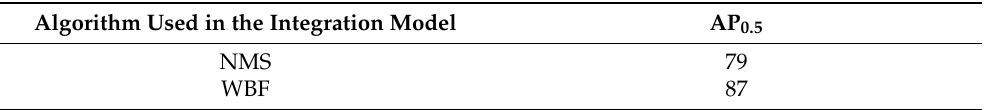
Table 7. Comparison of average accuracy of forest fire identification using WBF algorithm and NMS algorithm models. Algorithm Used in the Integration